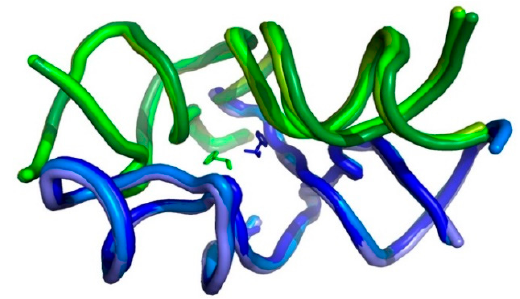
Figure 1. The Dimeric Proto-Ribosome (DPR) pocket. Overlap of the DPR fold, with the Peptidyl Transferase Center (PTC) at its core, as found in the high resolution structures of archaea (Protein Data Bank (PDB) code 1VQ6), bacteria (PDB code 2WDL), and eukarya (PDB code 3U5D), portraying the extreme tertiary conservation of this region. A-DPR monomers in blue hues, P-DPR monomers in green hues, with the reactants (PDB code 2WDL) positioned at the bottom of the cavity. The pocket is projected approximately along the symmetry axis. The elbows of the L-shape monomers point into the page.